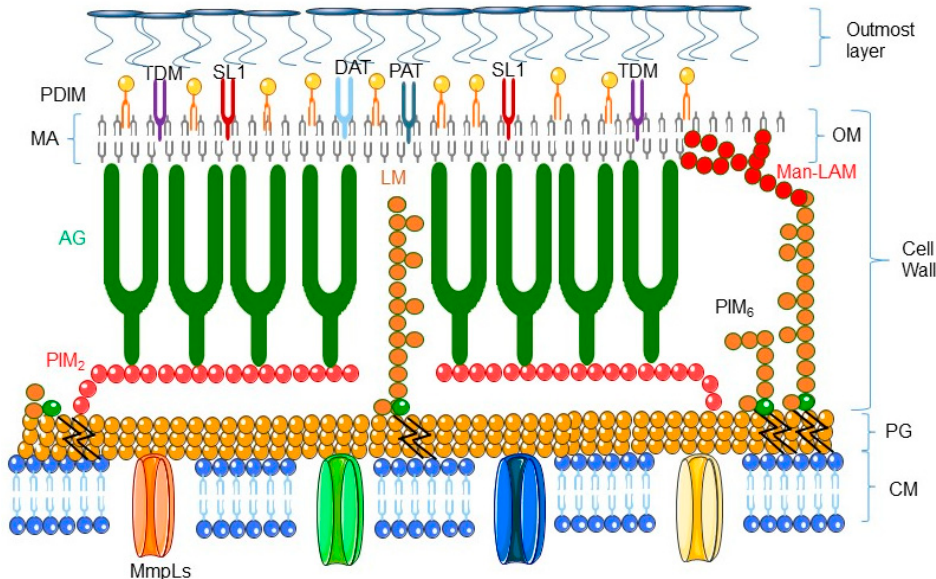
Figure 1. Schematic representation of the cell envelope of Mycobacterium tuberculosis (adapted from [2]). The cell envelope of M. tuberculosis includes an inner cell membrane (CM), a network of peptidoglycan (PG) with covalently attached macromolecules: AG, PIM 2 , PIM 6 , LM, and Man-LAM; an outer membrane (OM) composed of mycolic acid (MA), attached to TDM, DAT, PAT, PDIM, and SL-1; and an outmost layer of polysaccharides and proteins. AG: arabinogalactan; DAT: diacyltrehalose; LM: lipomannan; Man-LAM: mannose-capped lipoarabinomannan; PAT: poliacyltrehalose; PDIM: phthiocerol dimycocerosate; PIM 2 : phospho- myo -inositol-dimannoside; PIM 6 : phospho- myo -inositol-hexamannoside; MmpL: mycobacterial membrane protein large; TDM: trehalose dimycolate; SL-1: sulphoglycolipid.